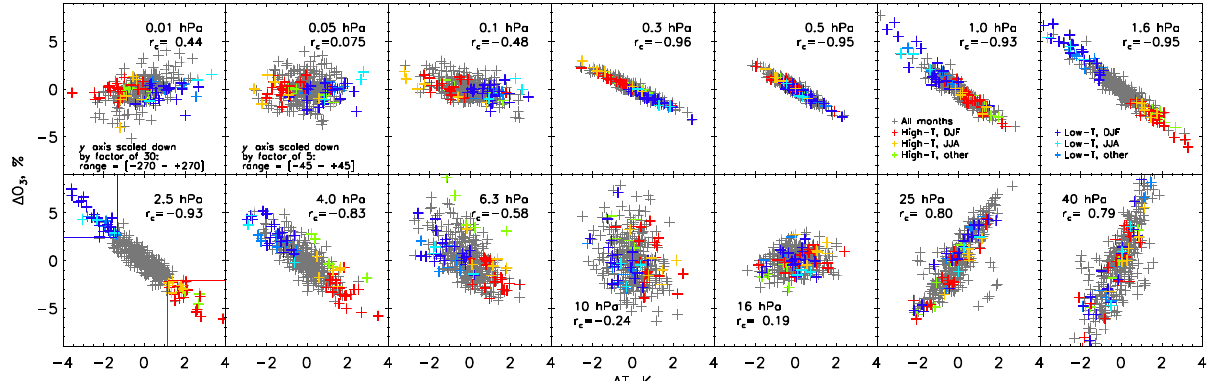
Figure 2. Regression of equatorial (20 ◦ N–20 ◦ S) ozone and temperature anomalies (following 13-month smoothing and monthly deseason- alising) from the CCM SOCOL model in specified-dynamics mode for pressure levels 0.01 to 40hPa ( ∼ 80–22km). Grey crosses are for all other months in January 1983–October 2012. Coloured crosses in each plot are determined at 2.5hPa (lower left, and plotted as diamonds in Fig. 1) by those within regions defined by the red (high- T events) and blue lines (low- T events); red crosses are for high- T events in December, January, and February (DJF); yellow are for high- T events in June, July, and August (JJA); and green are for “other” high- T events. Dark blue, turquoise, and blue represent DJF, JJA, and “other” low- T months, respectively (see also legends in 1.0 and 1.6hPa plots). Correlation coefficients are given for all crosses together. The y scale has been decreased by a factor of 30 and 5 at 0.01 and 0.05hPa, respectively, as indicated in the